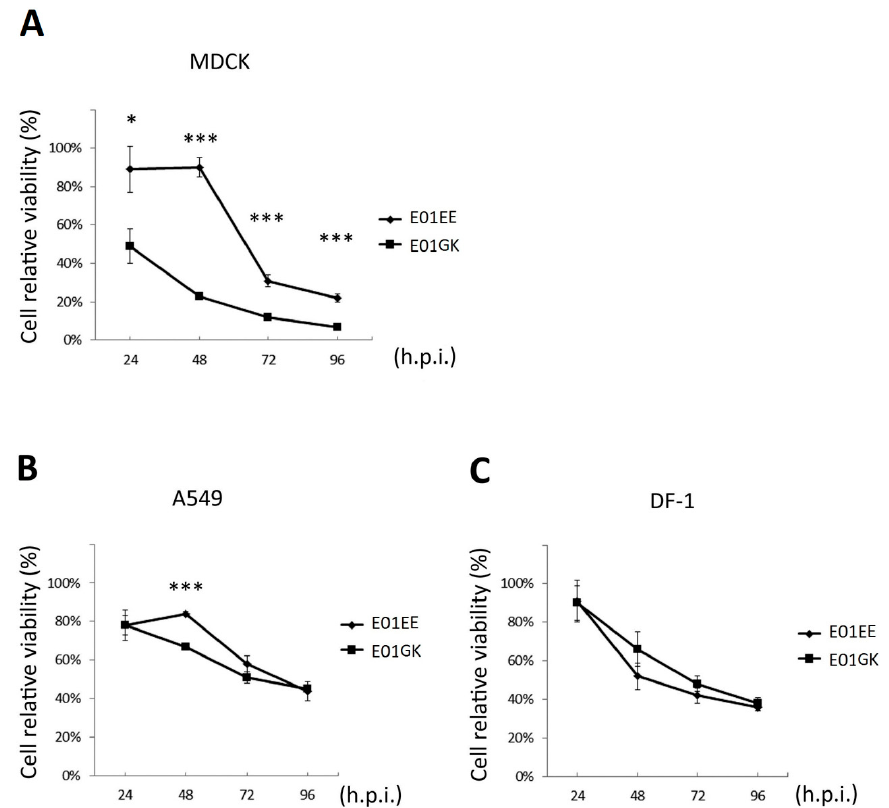
Figure 3. The relative viability of the virus infected cells was quantified using 3-(4,5-dimethylthiazol-2-yl)-2,5-diphenyltetrazolium bromide (MTT) assay. MDCK, A549 and